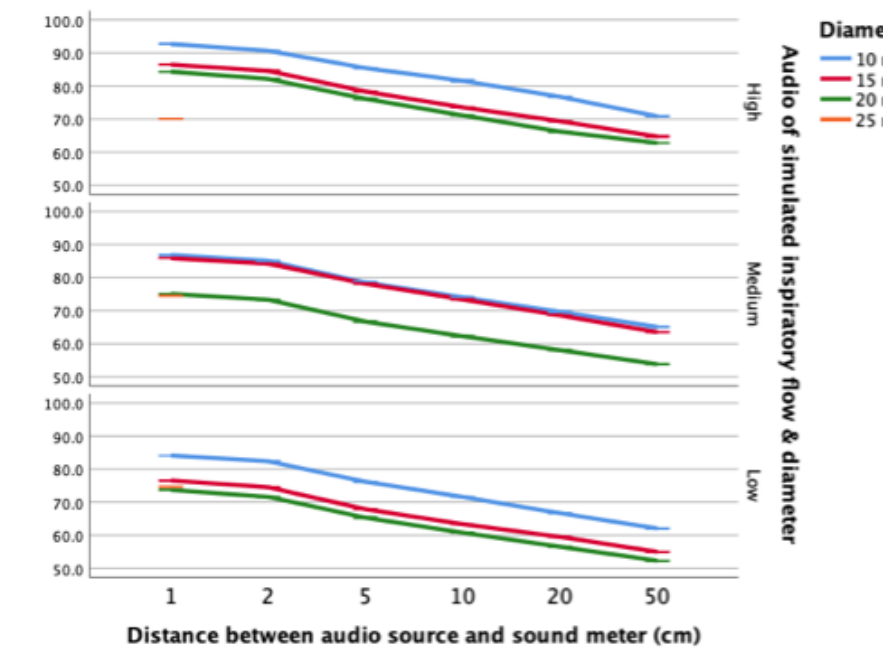
Figure 6. Sound levels of audio samples by distance, flow rate & mouth